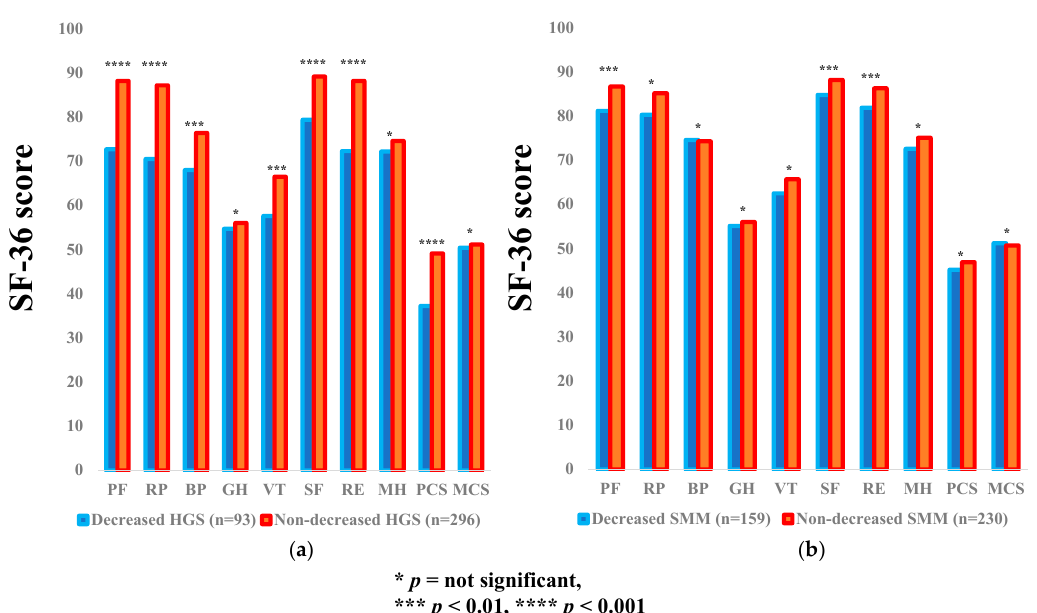
Figure 1. The SF-36 scores across 10 items in the decreased and non-decreased HGS groups ( a ), and the decreased and non-decreased SMM groups ( b ) for all cases ( n = 389). The average scores in each item of the SF-36 were plotted.